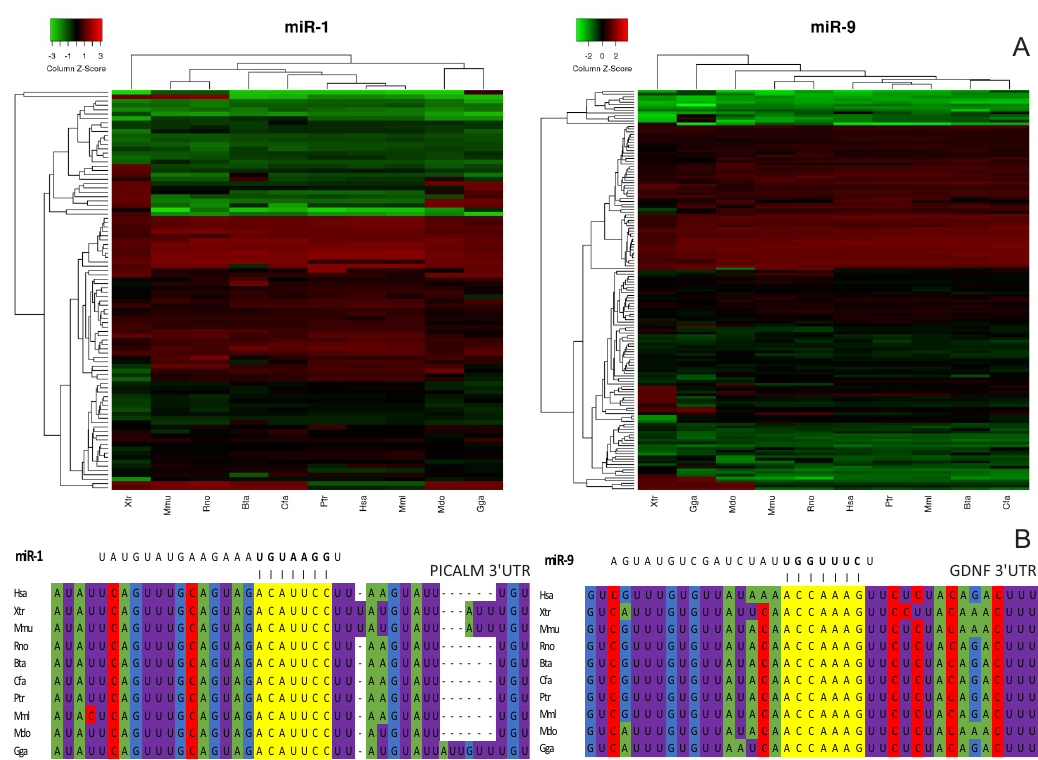
Figure 6. Conservation of target responsiveness over miRNA interaction. ( A ). Heatmaps of Context++Scores for miR-1 and miR-9 predicted targets among 10 vertebrate species. Negative Context++Score values are represented in green, positive values are represented in red, and near zero values are represented in black. Lower Context++Score values represent stronger miRNA regulation levels. Heatmaps for other miRNAs can be found in the Supplementary Figure S7. ( B ). Example of evolutionary conservation of the 3’UTR of two genes targeted by miR-1 (PICALM) or miR-9 (GDNF) in the genome of the ten vertebrate species. Yellow marks represent the miRNA binding site at the target mRNA